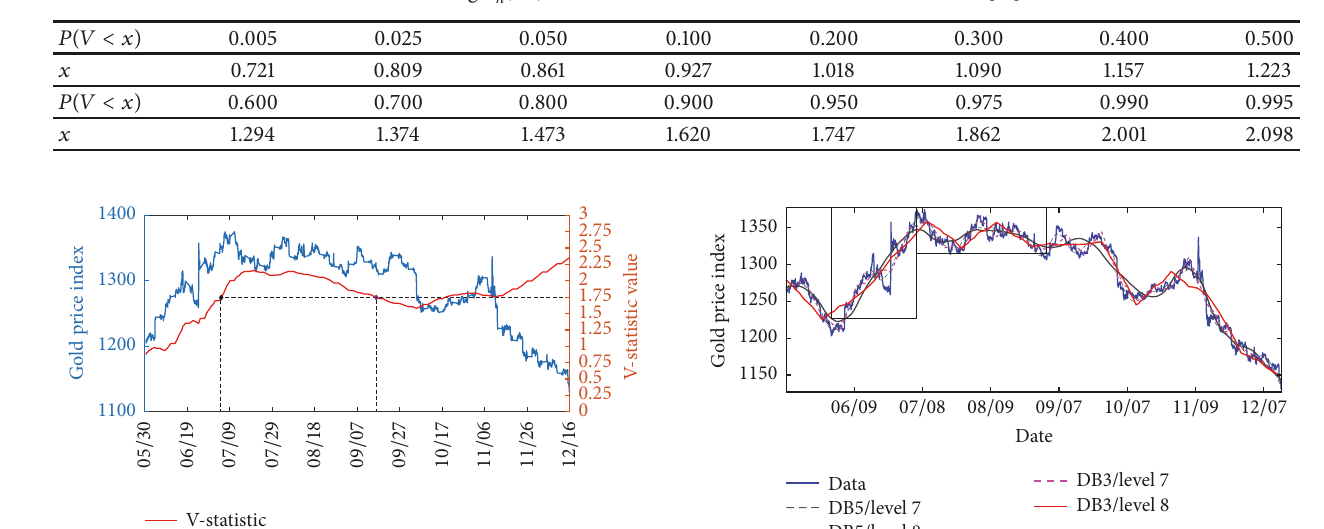
Table 2: Moving 𝑉 𝑛 (𝑡, 𝑠) -statistic under different level of the critical value [21].